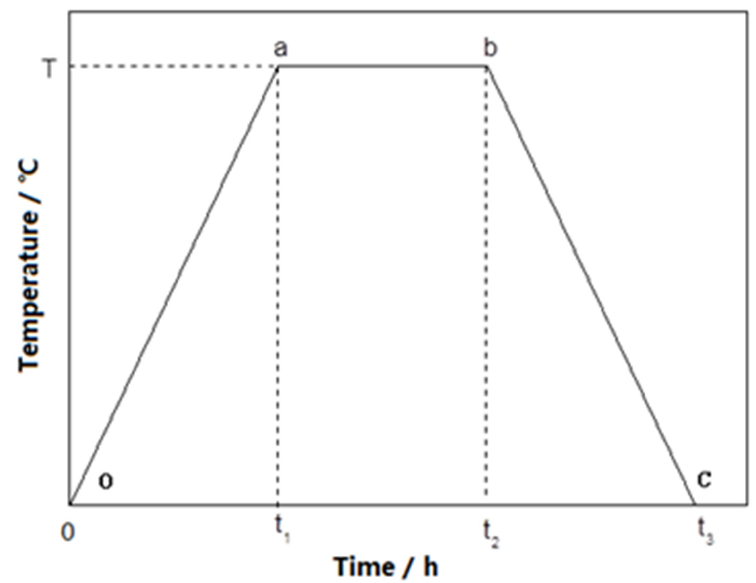
Figure 2. Chart of diffusion annealing